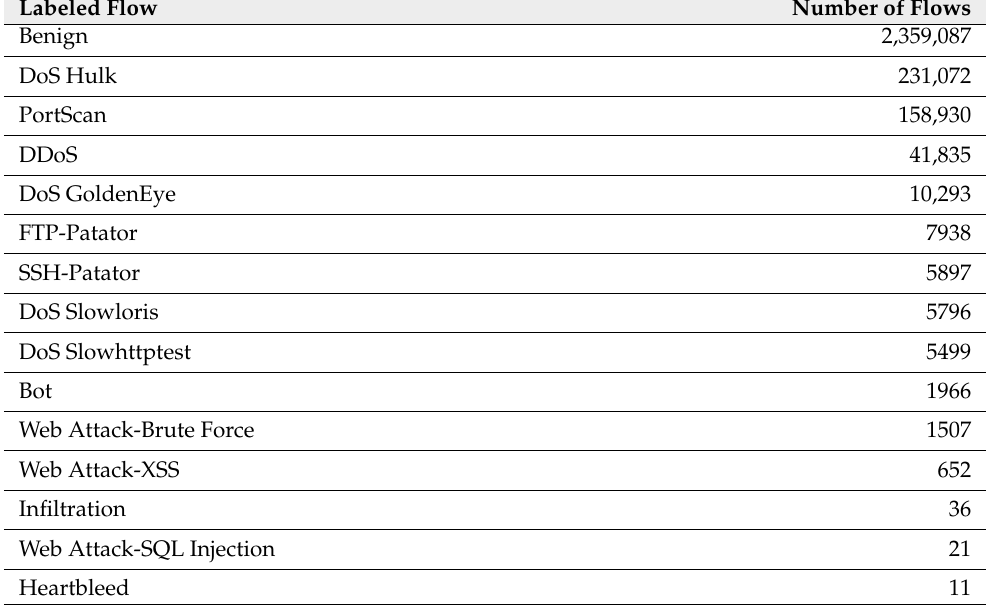
Table 2. Instance occurrence for the different flows in the CICIDS2017